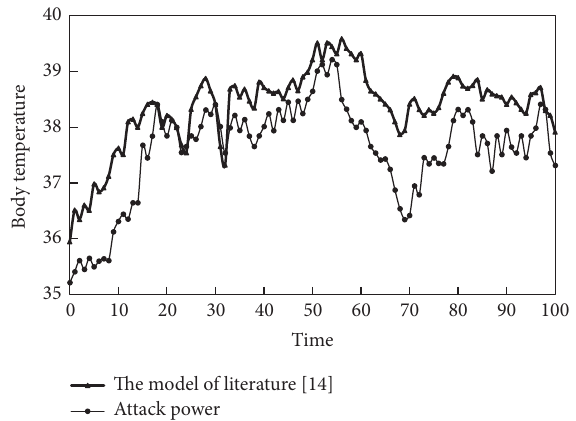
Figure 11: The change curve of the measured body temperature and the actual attack intensity with the model of literature [14].